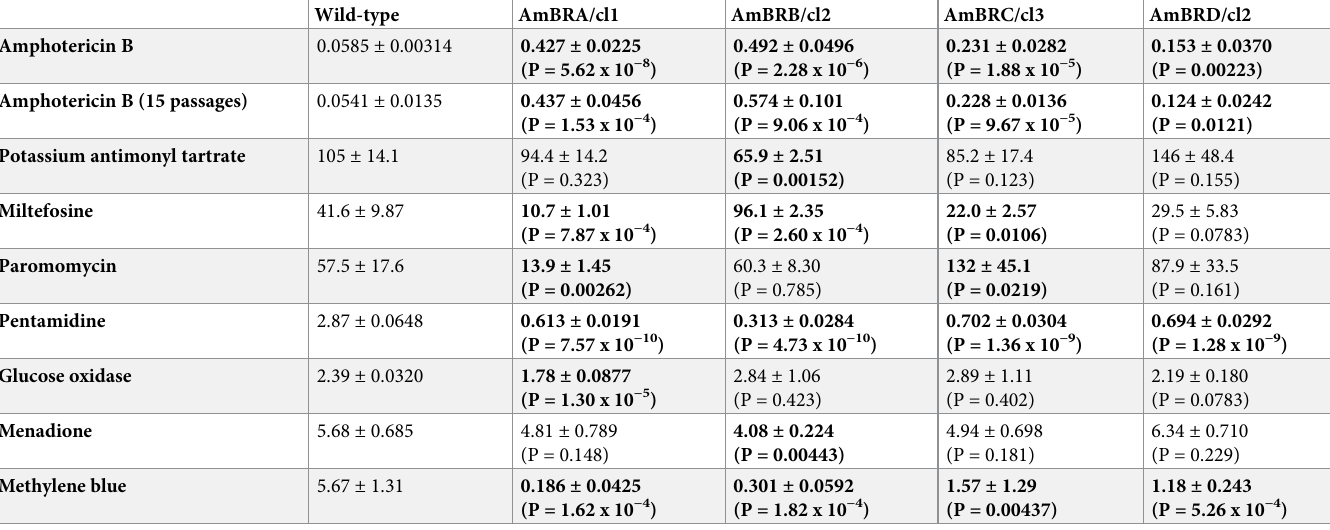
Table 1. Sensitivity of lines selected for AmB resistance to other antileishmanial